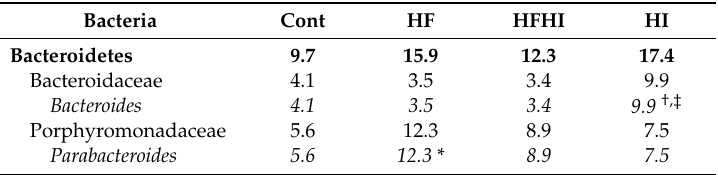
Table 3. Abundance of gut microbiota at week 30.